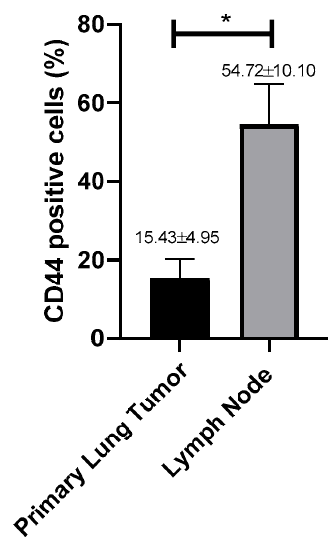
Figure 1. CD44 is overexpressed in primary tumors and lymph nodes, and is correlated with poor survival. ( A ) Kaplan– Meier analysis of OS, according to the expression of CD44 mRNA by using lung cancer online microarray datasets software. ( B ) Representative images of IHC for CD44 expression in primary tumors and lymph node metastases ( left ) and bar graph showing the expression of CD44 in primary tumors and metastatic lymph nodes of lung cancer patients ( right ). ( C ) Flow cytometry results showing the percentage of CD44 positive cells in primary tumors and metastatic lymph nodes analyzed by flow cytometer ( left ) and bar figure showing the average of CD44 positive cells in primary lung tumors and metastatic lymph nodes ( right ). * p < 0.05.